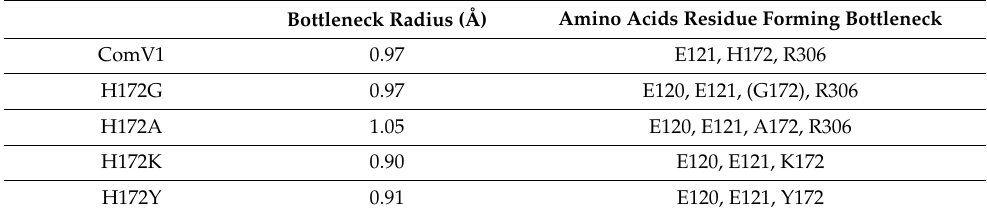
Figure 4. Structures of ComV1 and its mutants analyzed with molecular dynamic simulation. ( a – e ), The simulated structure around the 172nd residue in ComV1 ( a ), H172G ( b ), H172A ( c ), H172K ( d ), and H172Y ( e ) at an early excited state. The protein and the estimated ion gating pathway are shown as green and yellow ribbons, respectively. The figure in the frame is the structure near the 172nd residue observed vertically from the ion tunnel. The first structural models were built with homology modeling using the structure of PDBID: 7E71 as the template. Table 1. Properties of the ion gate bottleneck near the 172nd residue in the early excited state. The bottleneck radius and amino acids forming the bottleneck was calculated using molecular dynamic simulation.